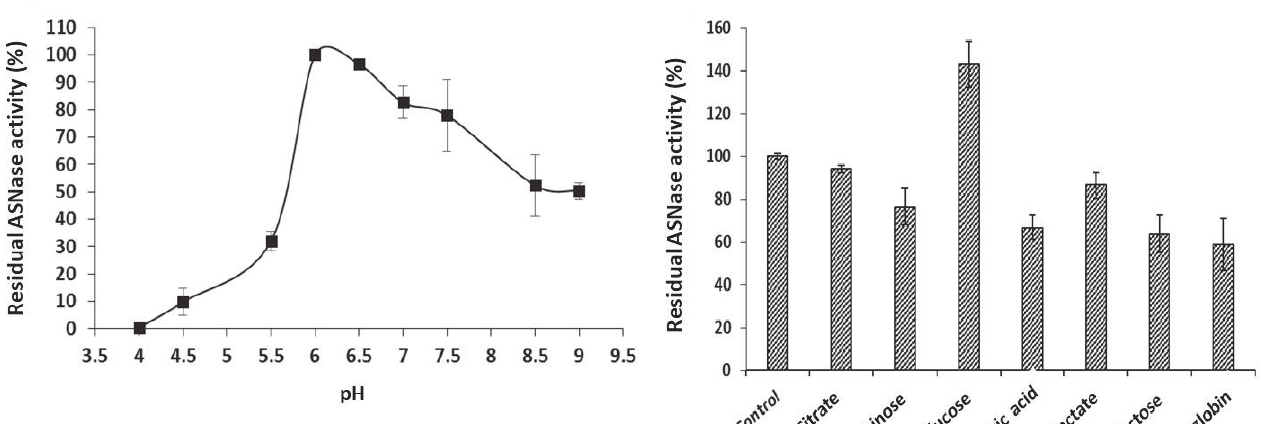
Fig. 3 – Effect of pH on l -asparaginase from Enterobacter sp. strain M55